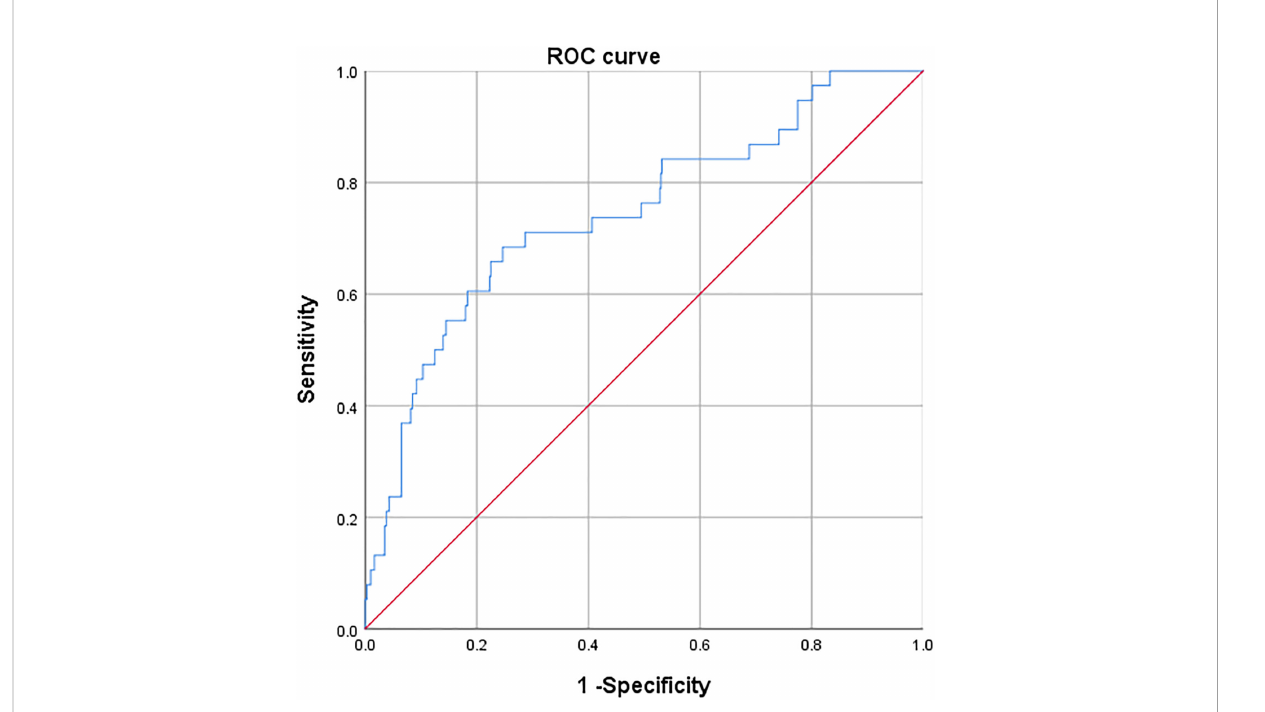
FIGURE 3 Receiver operating characteristic curve of three independent risk factors for predicting postoperative pulmonary complications.